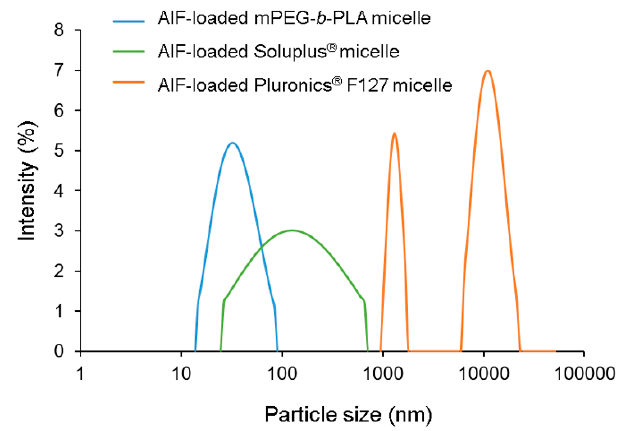
Figure 4. Representative size distribution profiles of alpinumisoflavone (AIF)-loaded mPEG- b -PLA micelles, AIF-loaded Soluplus ® micelles, and AIF-loaded Pluronics ® F127 micelles. Table 2. Characteristics of alpinumisoflavone (AIF)-loaded micelles ( n = 3, mean ± standard deviation [SD]).